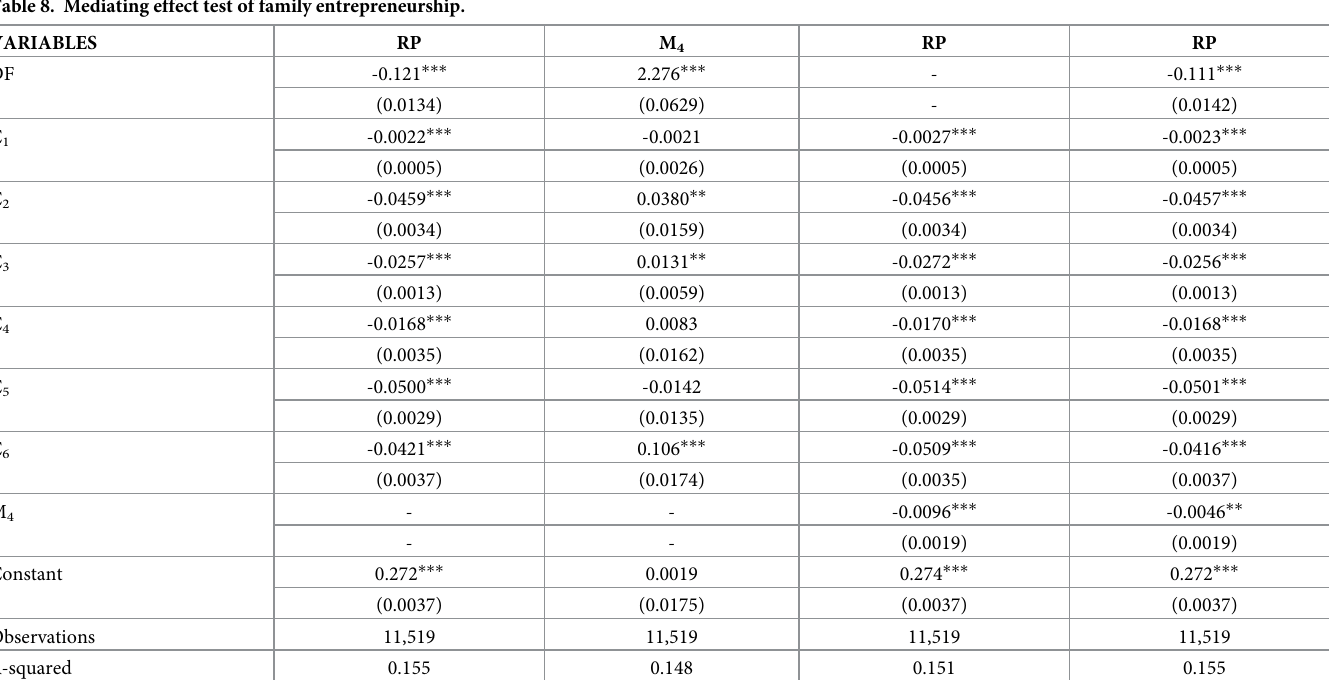
Table 8. Mediating effect test of family